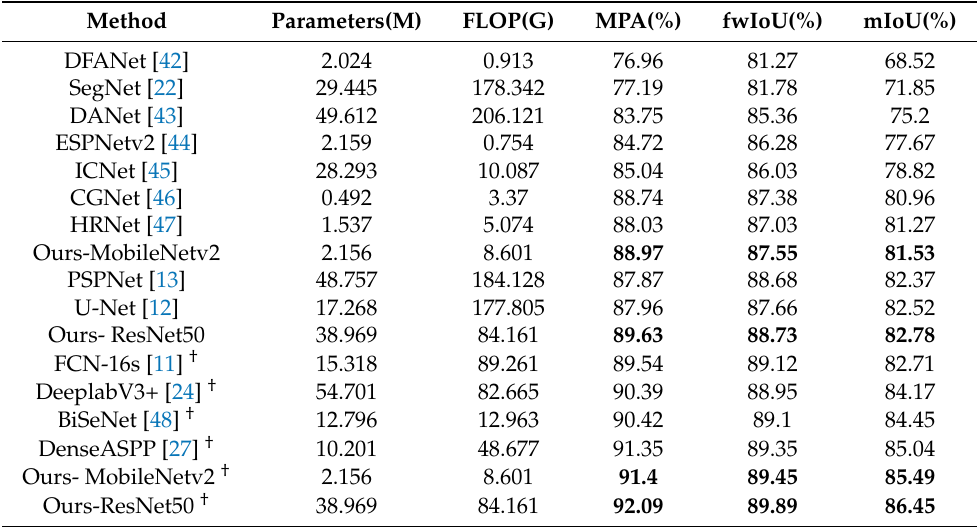
Table 6. Results on LandCover testing set. Methods pre-trained are marked with ‘†’ (bold represents the best result).